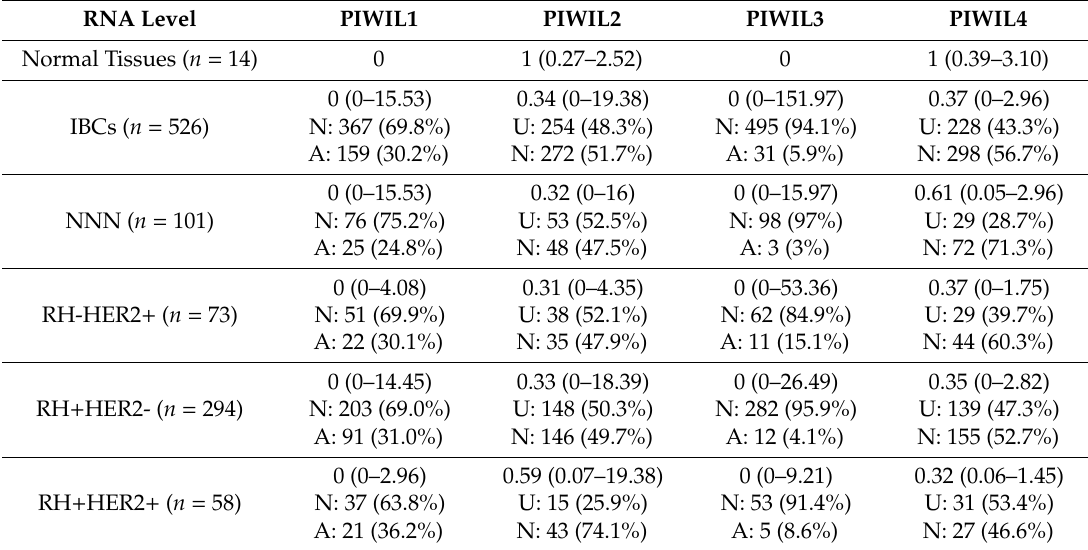
Table 3. PIWIL1-2-3-4 mRNA levels of expression in a series of IBCs ( n = 526) with molecular subtypes. RNA Level PIWIL1 PIWIL2 PIWIL3